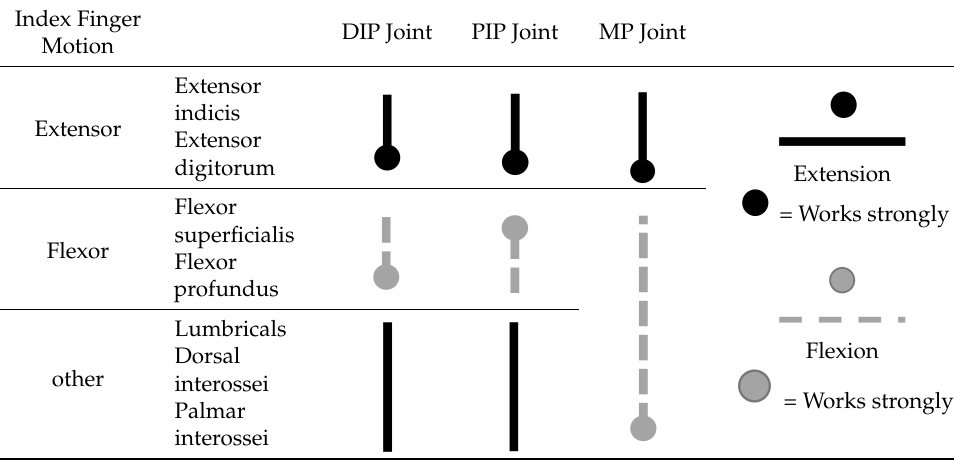
Table 3. Muscles involved in index movements.